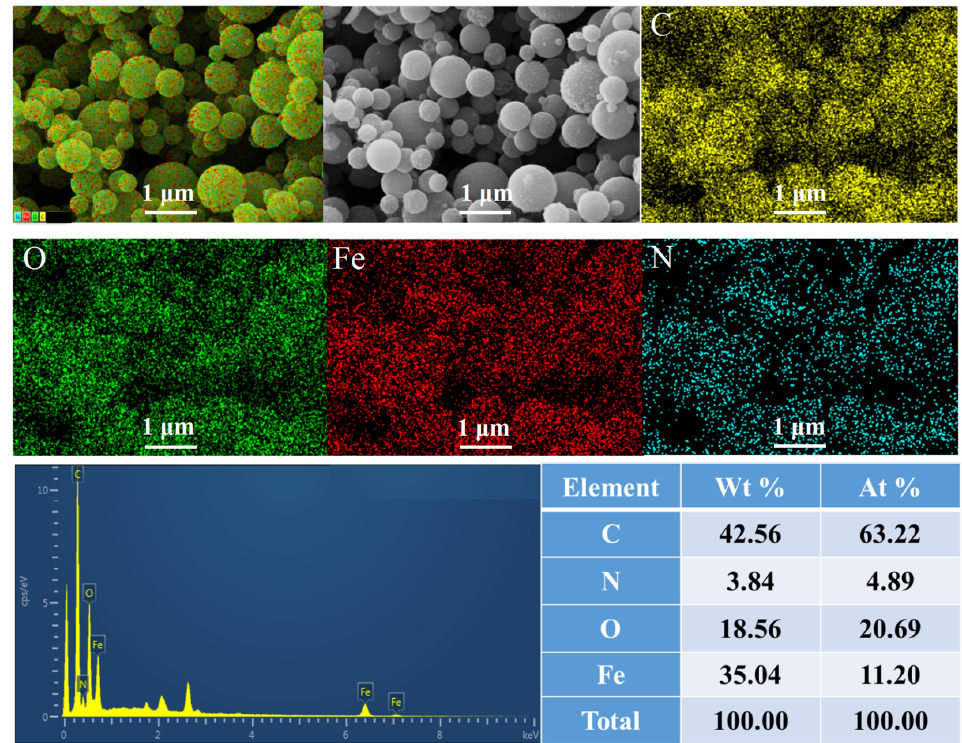
Figure 3. EDS mapping and element analysis result of the Fe 3 O 4 @C sample.